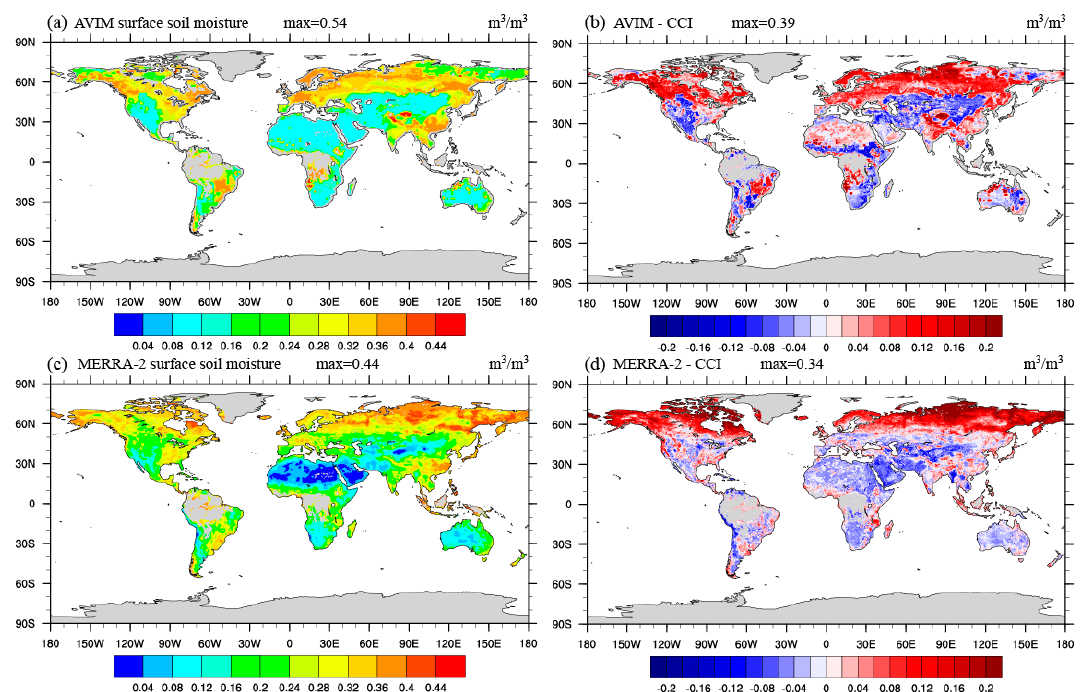
Figure 3. Monthly mean surface soil moisture in the AVIM ( a ) and MERRA-2 ( c ) datasets, and the differences between the CCI dataset and the AVIM ( b ) and MERRA-2 ( d ) datasets.